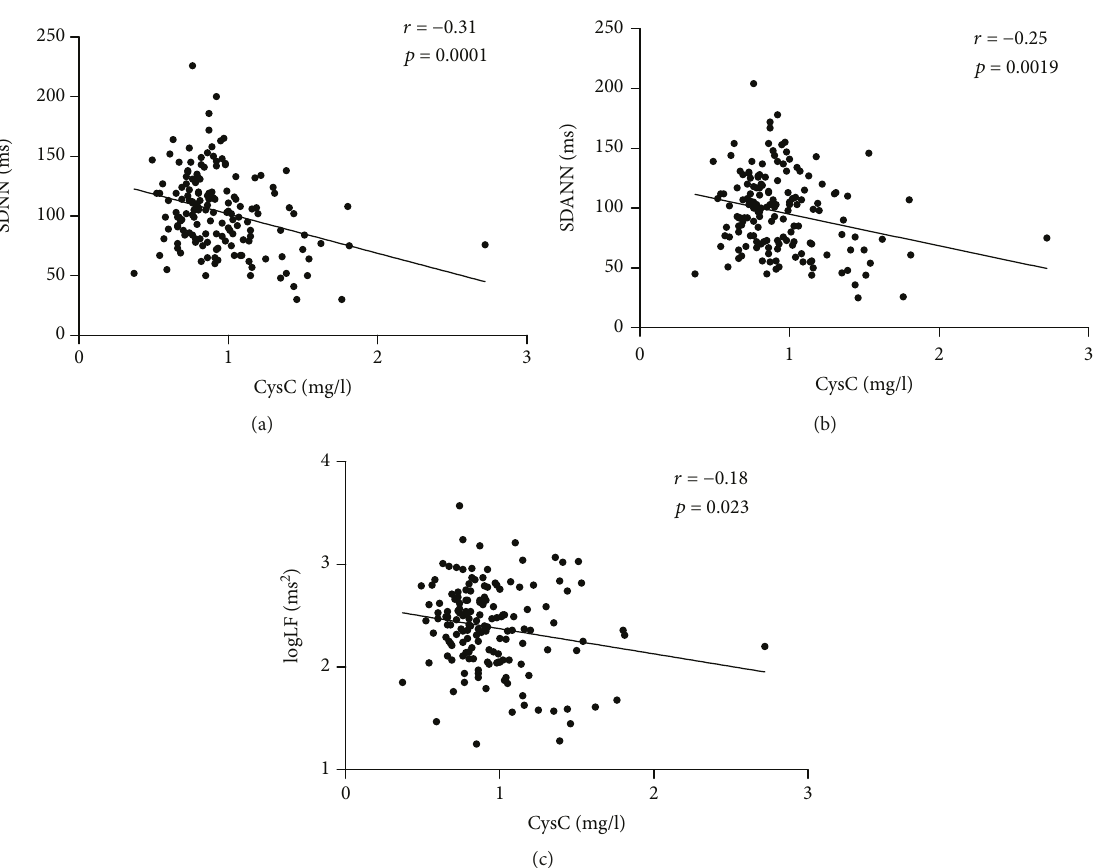
Figure 2: Relationship between cystatin C (mg/l) and HRV indexes in all subjects. Correlation assessed by Pearson analysis. (a) Cystatin C (mg/l) with SDNN (ms), (b) cystatin C (mg/l) with SDANN (ms), and (c) cystatin C (mg/l) with logLF (ms 2